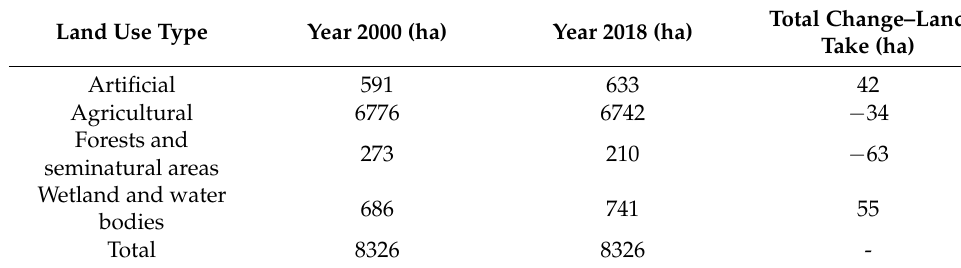
Table 1. Land use dynamics in Futog between 2000–2018.